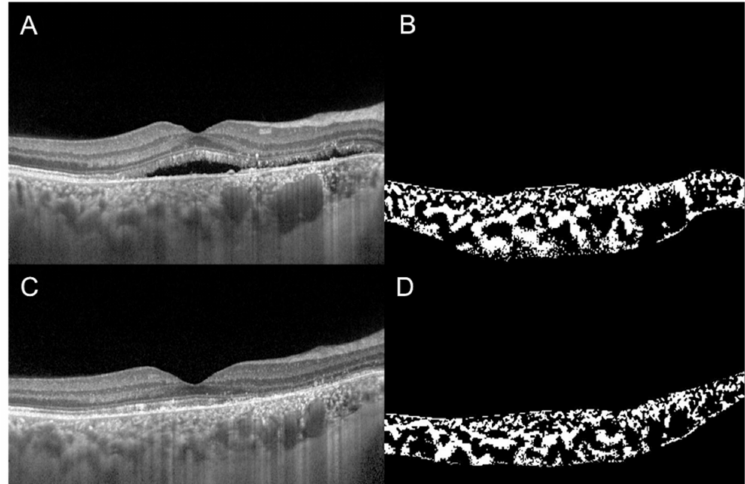
Figure 3. Choroidal vascularity index, calculated by the means of automated algorithm in a 56-year-old man with chronic central serous chorioretinopathy (CSC), before ( A , B ) and 3 months after ( C , D ) half-dose full-fluence photodynamic therapy, was 58.7% and 54.4%,